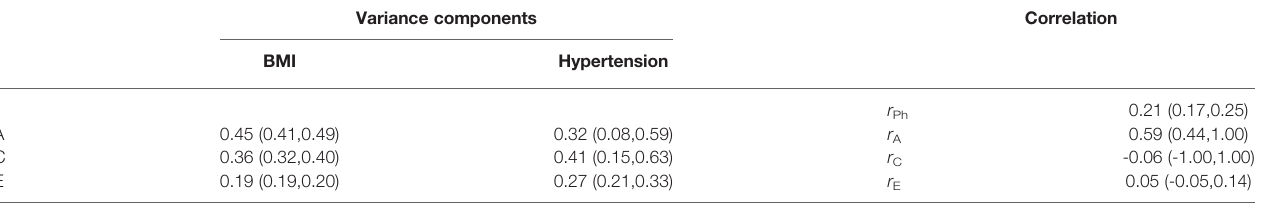
TABLE 6 | Parameter estimates (95% CIs) from the best- fi tting bivariate ACE full model of BMI and hypertension.